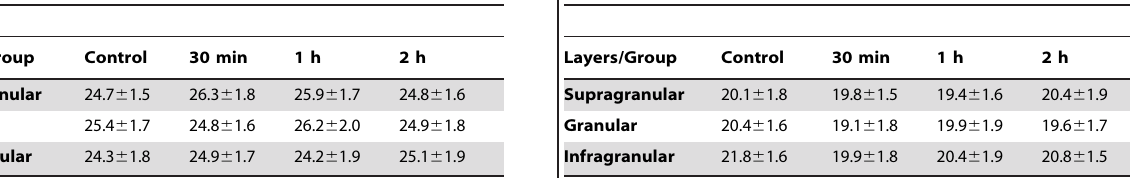
Table 3. Acute sensory stimulation does not affect the numerical densities of ER b -positive cells across cortical layers of